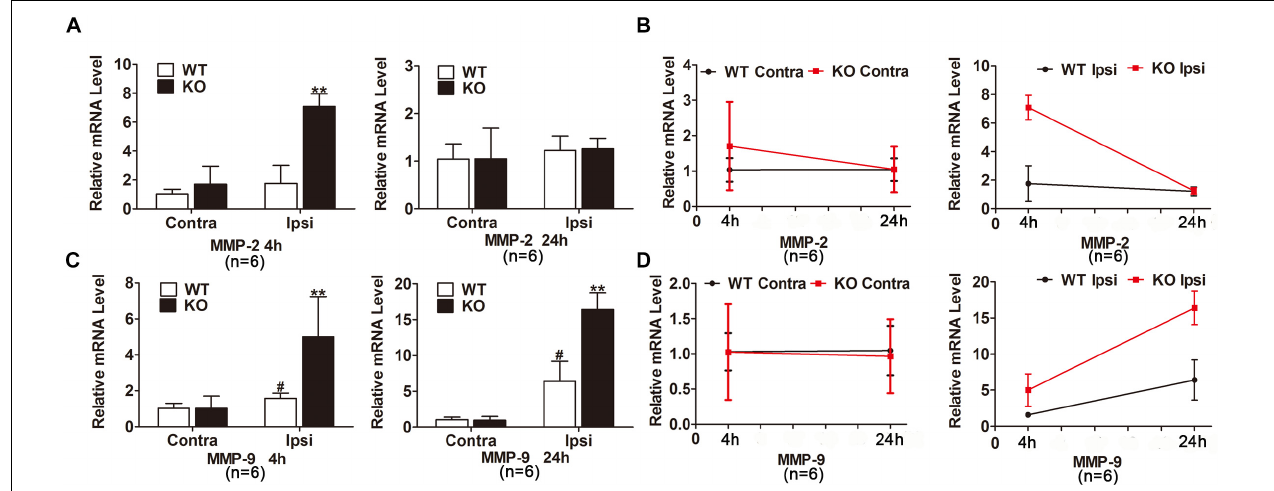
FIGURE 5 | MMP-2 and MMP-9 expression were increased in the ischemic brain of KO mice. (A – D) Bar graphs and linear graphs showing the mRNA levels of MMP-2 (A,B) and MMP-9 (C,D) in ipsilateral and contralateral hemisphere of cerebral ischemia. The IgG relative intensity was measured using ImageJ. Data are expressed as mean ± SD, n = 6 mice per group. ∗∗ P < 0.01 vs. WT group, # P < 0.05 vs. sham